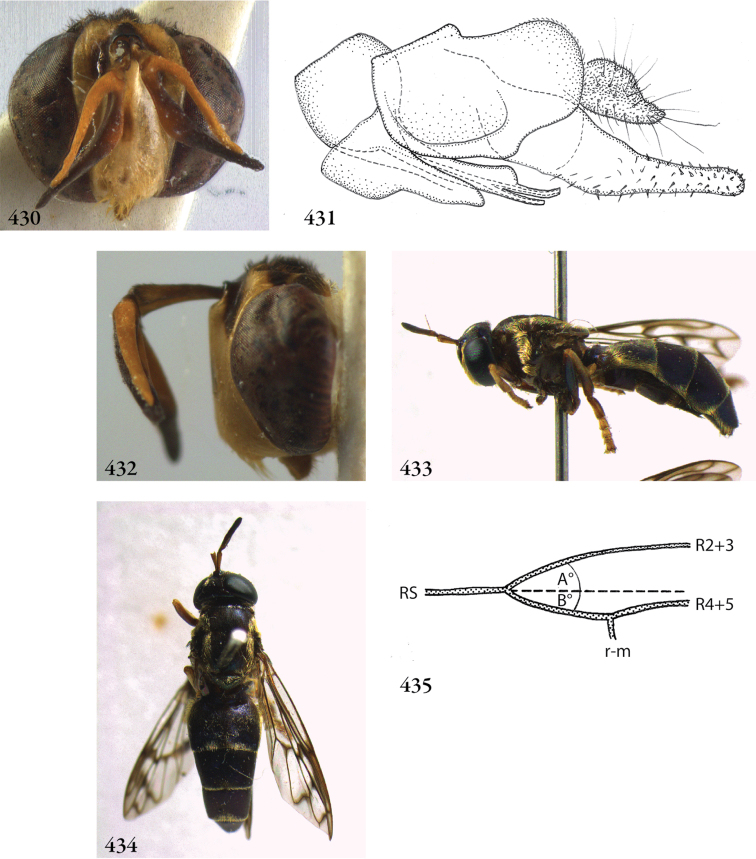
430–432 Undescribed genus #2 species MCR-2 male (Costa Rica, coll. RMNH): 430 head frontal 431 genitalia lateral 432 head lateral 433–434
Microdon sharpii female (New Guinea, coll. BMNH, compared with holotype) 433 habitus dorsal 434 habitus lateral 435 Wing veins in Microdontinae (wing base on left side). The dashed line indicates an (imaginary) apical extrapolation of vein RS. In Microdontinae, vein R2+3 is strongly curved basally, resulting in angle A always being larger than angle B.